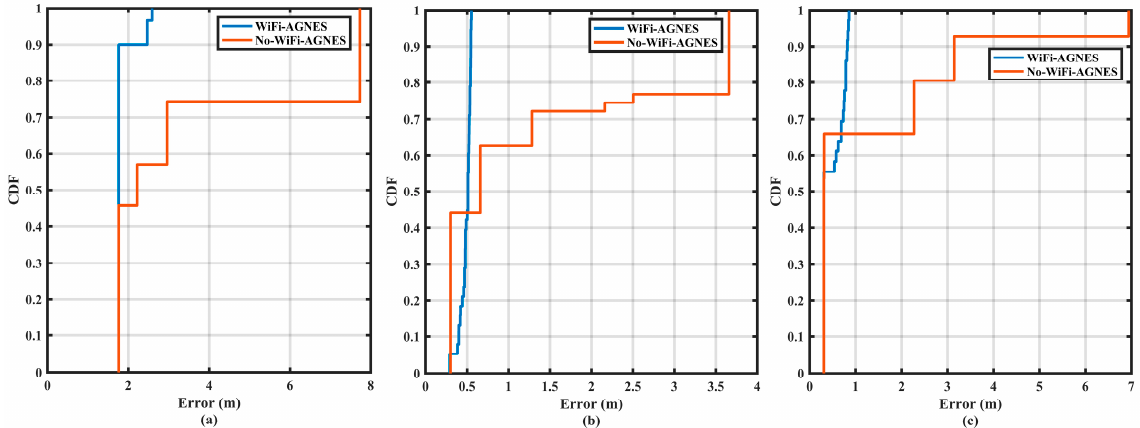
Figure 14. CDF for the evaluated 3 control points during the third experiment. ( a ) P3; ( b ) P9; ( c ) P12.